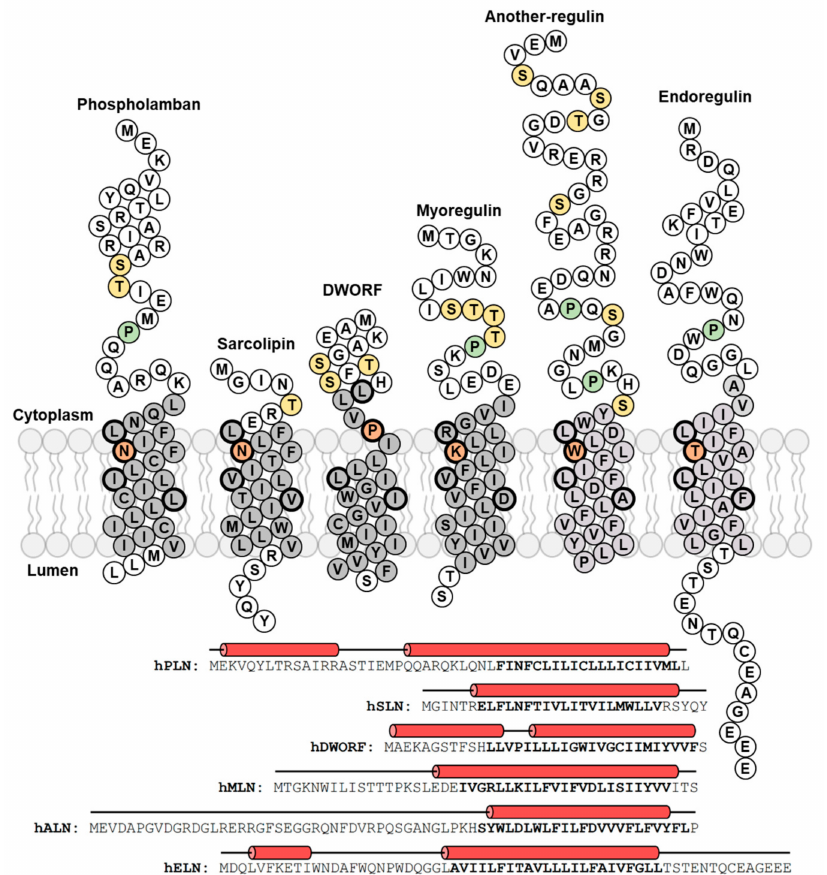
Figure 1. Topology models and sequence alignments for the regulin family of small transmembrane peptides. For the topology models, the transmembrane domains are highlighted in gray, Asn 34 in PLN and Asn 11 in SLN are highlighted in orange. Polar residues in MLN, ALN, and ALN that align with Asn 34 of PLN and Asn 11 of SLN are also highlighted in orange. Potential phosphorylation sites (yellow) and proline residues (green) are indicated. Pro 15 of DWORF aligns with Asn 34 of PLN and Asn 11 of SLN and is colored as an essential residue (orange). For the sequence alignments, the predicted transmembrane domains are in bold and predicted helical regions are indicated as red